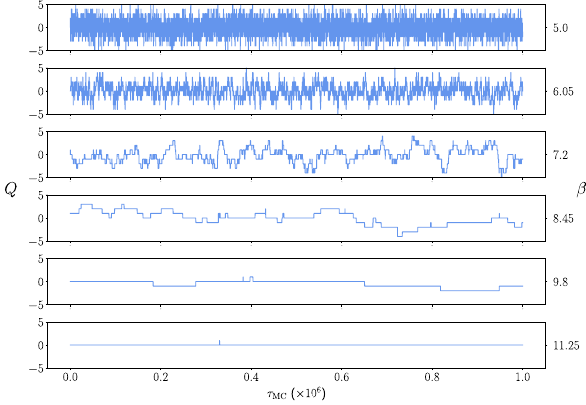
Fig. 1 Monte Carlo history of the topological charge Q for increasing values of β in a Markov chain of 10 6 HMC configurations